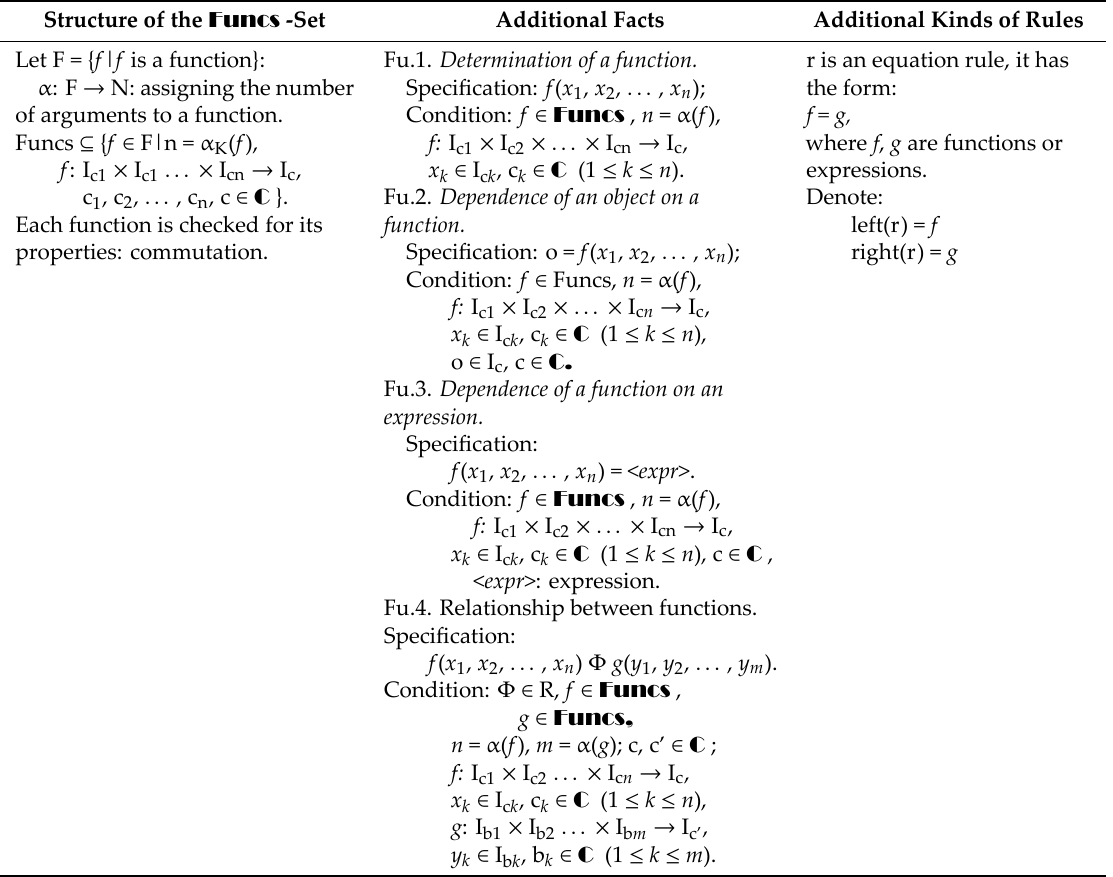
Table 3. Structure of the Funcs